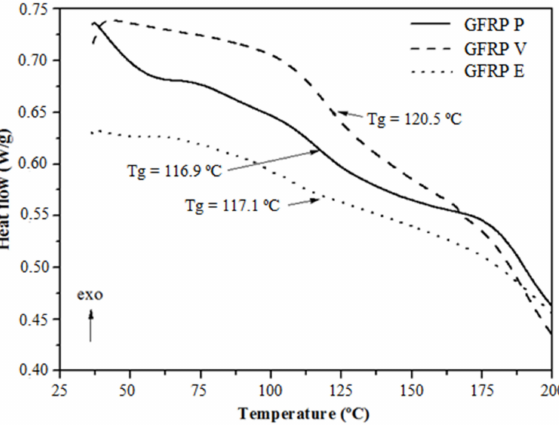
Figure 5. DSC curves of GFRP bar with matrix polyester (P), vinyl ester (V), and epoxy (E).